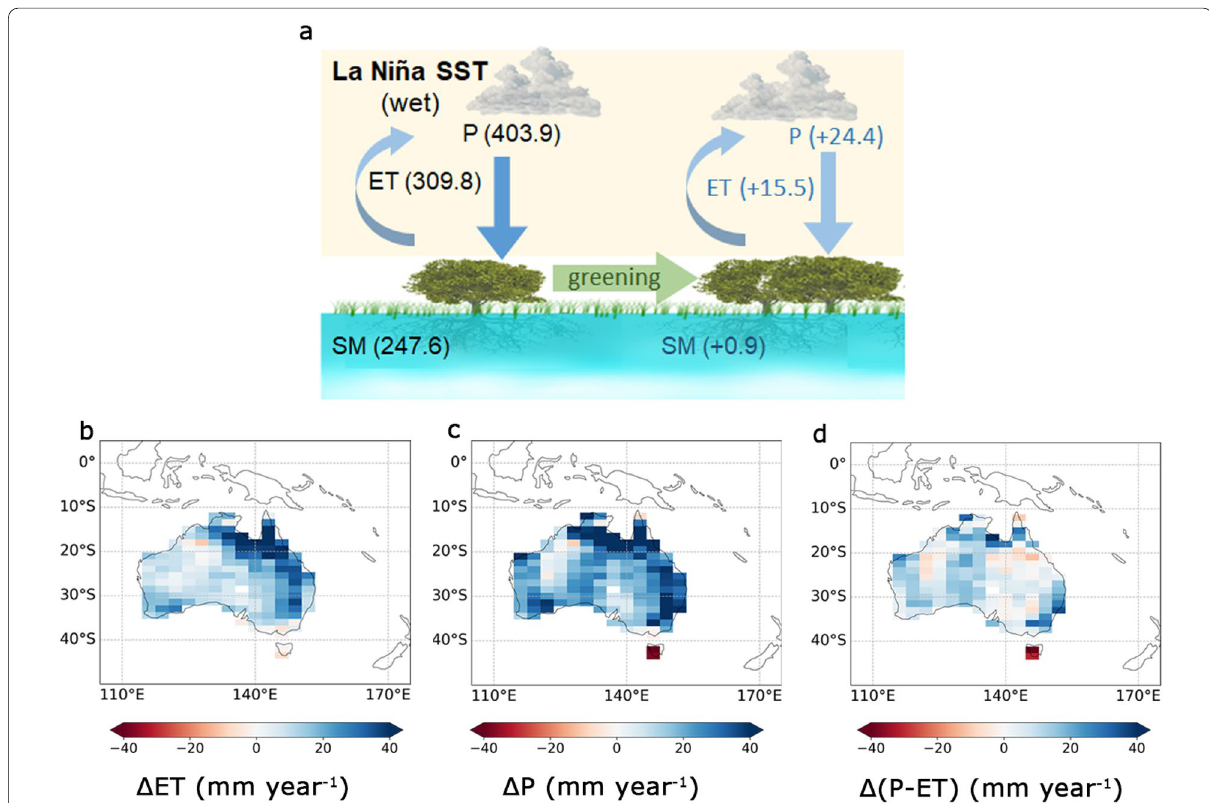
Fig. 5 Conceptual illustration and the spatial patterns of the modeled changes in water yield under greening for La Niña SST forcing. a The biosphere–atmosphere iterations before and after greening for hydrological balance variables ET (mm year − 1 ), precipitation (P, mm year − 1 ), and soil moisture (SM, mm). b – d The spatial patterns of the changes in ET, precipitation (P), and water yield (P-ET) under